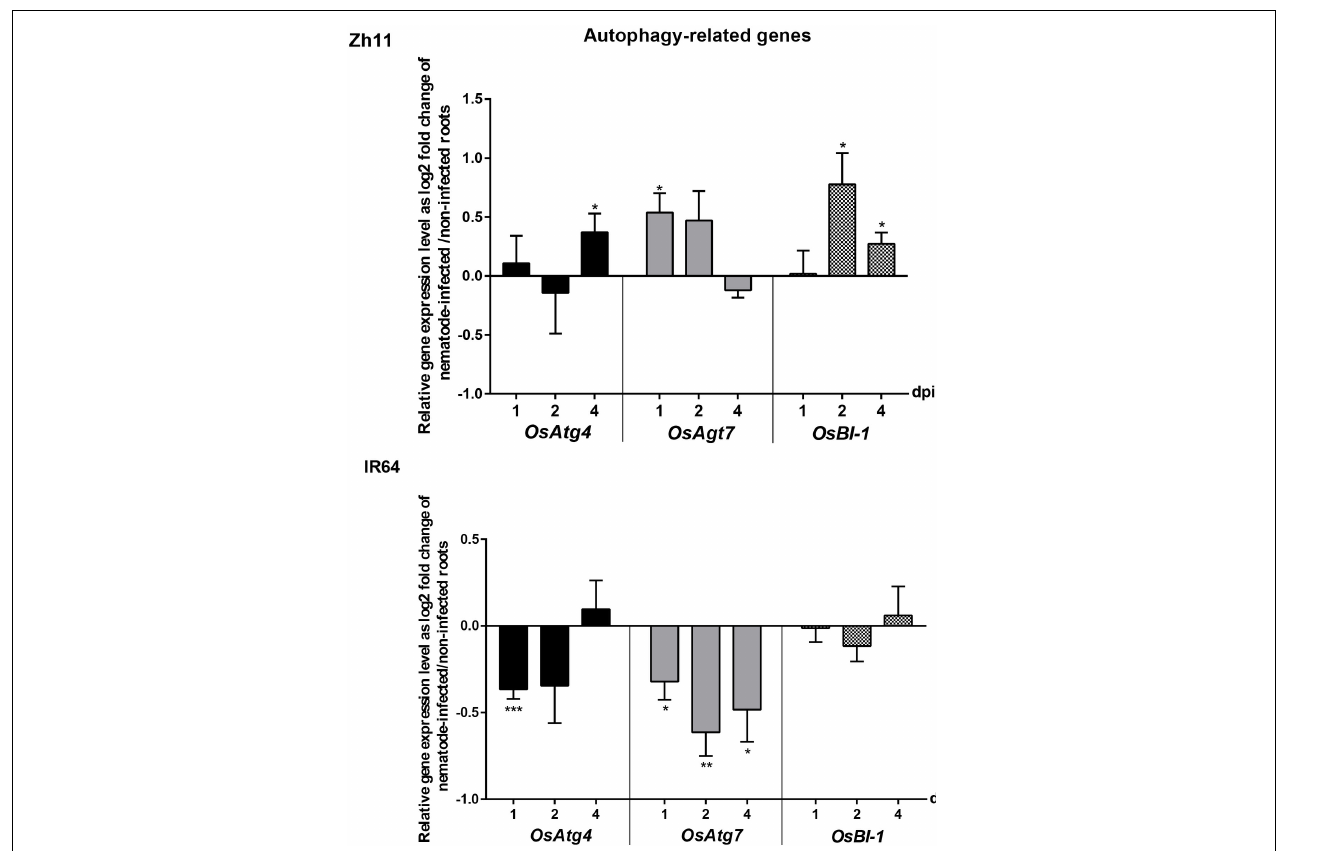
FIGURE 4 | Temporal expression pattern of genes involved in the autophagy process during the incompatible interaction in Zh11 and compatible interaction in IR64 with Meloidogyne graminicola . The gene expression patterns are presented in parallel for Zh11 and IR64. Ten root tips per sample were collected and pooled for inoculated and non-inoculated plants at 1, 2, and 4 days post nematode infection (dpi). Gene expression levels were measured by qRT-PCR in triplicates, for three independent biological repeats for each combination (genotype/treatment/time point) and normalised using the internal reference gene OseEF-1A (Os03g0177400). Bars represent at each time point the relative gene expression as log2 fold changes of the mean and standard error for nematode-inoculated root sample compared with uninfected control plants grown under the same conditions The result of the Student’s t -test comparing for each time point the gene expression in root inoculated vs. non-inoculated conditions is indicated above the bar when there is a significant difference of the means with p value < 0.05 (*), p ≤ 0.01 (**), or p ≤ 0.001 (***). Genes investigated: autophagy-related genes OsAtg4 (Os04g0682000) and OsAtg7 (Os01g0614900); BAX inhibitor OsBI-1 (Os02g0125300). upregulated upon nematode infection at 2 and 4 dpi ( Figure 4